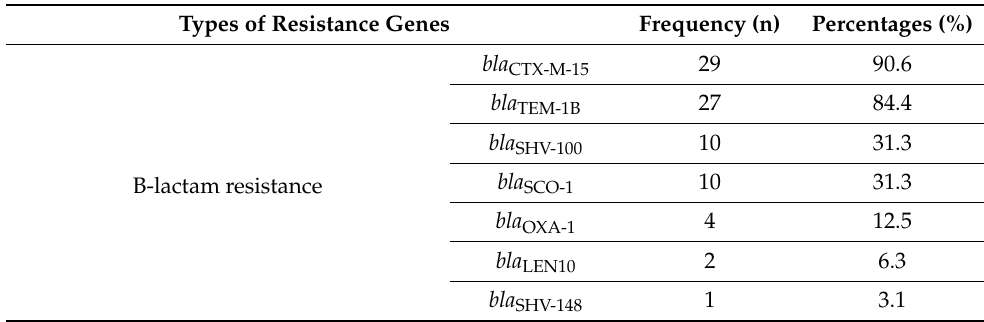
Table 2. Types and distributions of acquired antibiotic resistance genes (ARGs) in sequenced Klebsiella pneumoniae